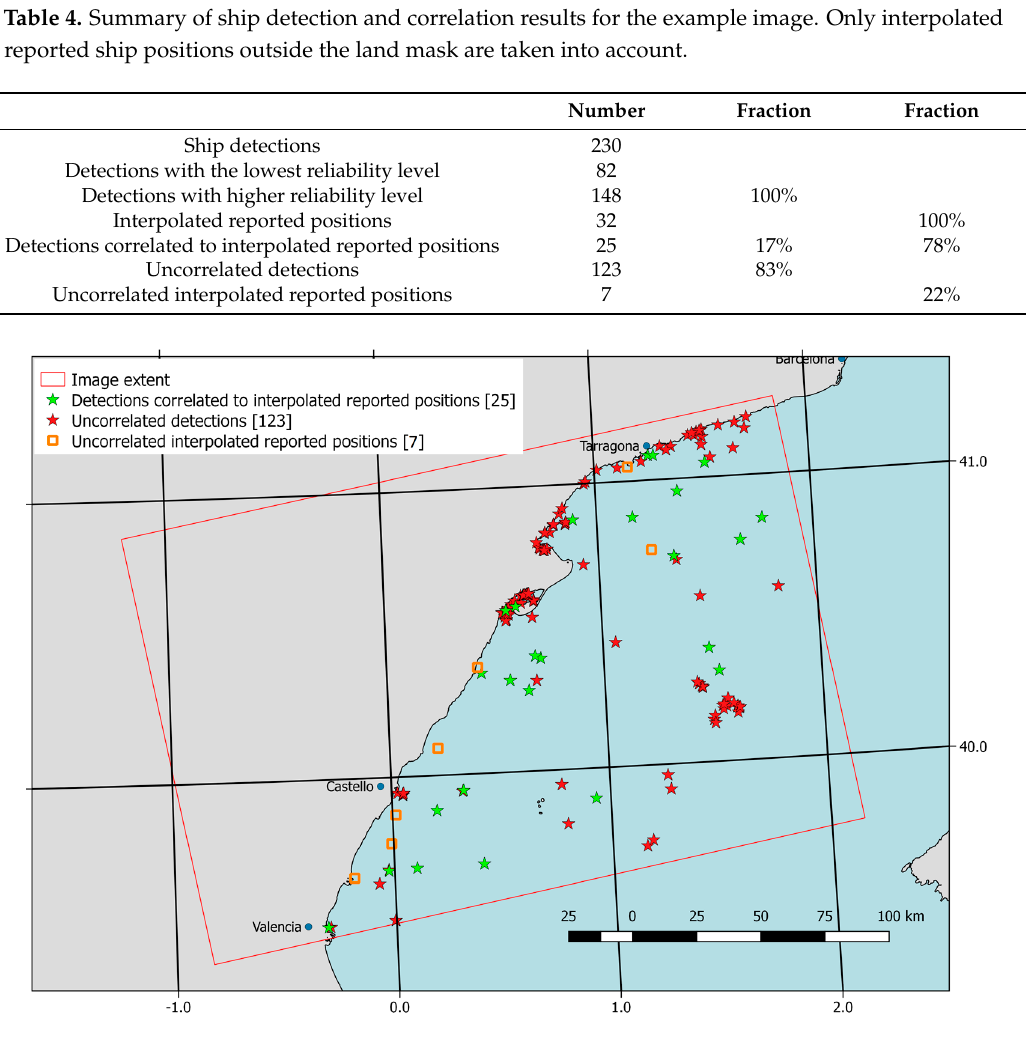
Figure 6. Map displaying the SUMO/SAR detections (correlated and uncorrelated) and the uncorrelated interpolated reported positions.